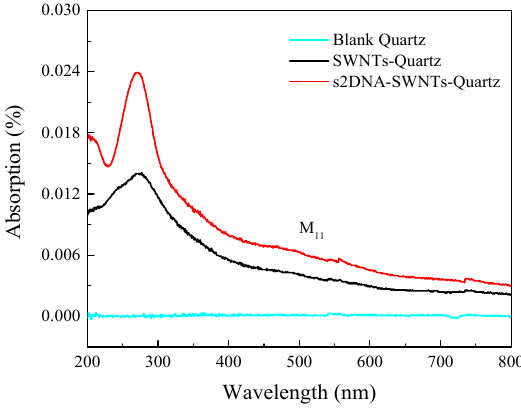
Figure 4. UV–vis absorption spectra of blank quartz (blue), SWNT–quartz (black), and s2DNA- SWNT–quartz (red).